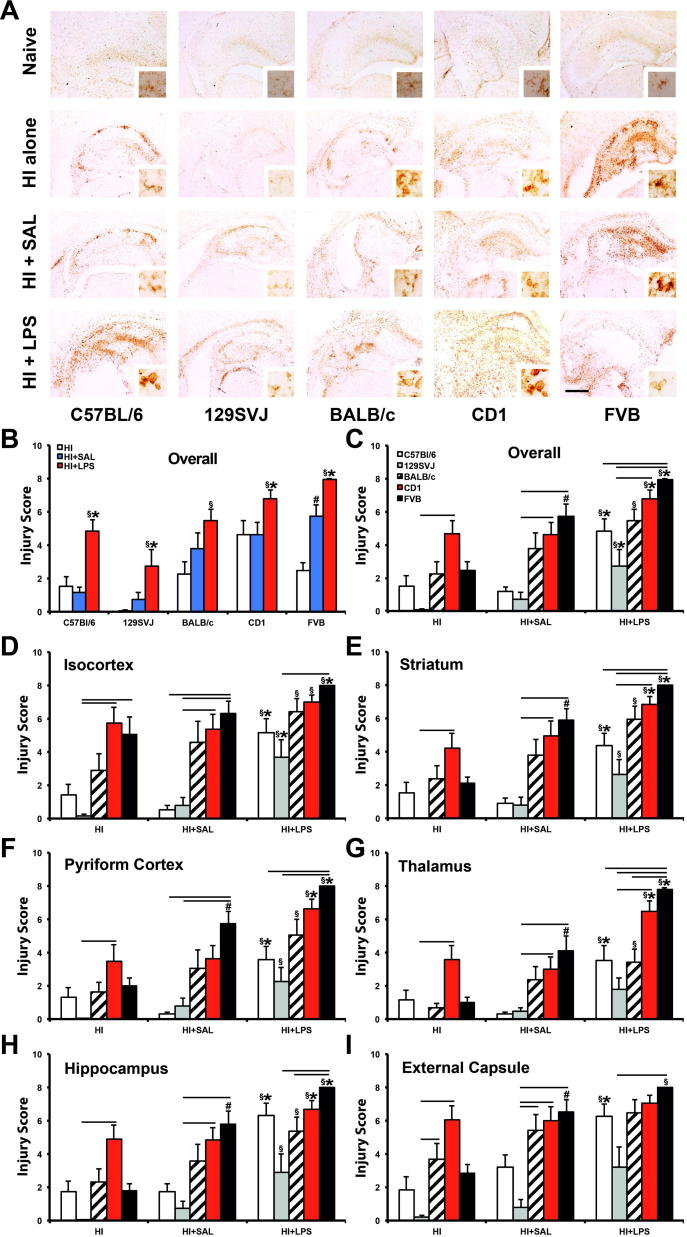
LPS sensitization to neonatal hypoxia–ischemia substantially increases microglial activation and neuronal cell loss on the C57BL/6, 129SVJ, CD1 and FVB background. (A) Microglial activation staining (alphaM) of coronal hippocampal sections of C57BL/6, 129SVJ, BALB/c, CD1 and FVB strains 48 h following hypoxia–ischemia. The upper row shows untreated naïve animals, second row shows mice exposed to hypoxic–ischemic insult alone (HI alone), third row those injected 12 h earlier with saline (HI + SAL), and lower row animals pre-treated with 0.6 μg LPS/g body weight (HI + LPS). Nissl staining used for neuronal cell loss scoring is shown in Fig. 1. Note the lack of microglial activation in the naïve group. The LPS-treated BALB/c strain showed minimal increase in microglial activation and neuronal cell loss, when compared to saline-treated controls. However, comparison with HI alone animals revealed a significant increase in combined injury score. Compared with animals not injected prior to hypoxia–ischemia, Saline administration elicited an increase in injury score overall (B, C) as well as in most FVB ipsilateral brain regions (D–I). Interstrain treatment comparison revealed that both CD1 and FVB background strains had the highest levels of combined injury score, with significance being reached when compared to 129SVJ animals (C–I). p < 0.05 for Kruskal–Wallis one-way analysis, followed by Dunn multiple comparison test (∗for HI + LPS vs. HI + SAL, §for HI + LPS vs. HI alone, #for HI + SAL vs. HI alone, overhead bar for interstrain treatment comparison). Bar scale = 0.5 mm.